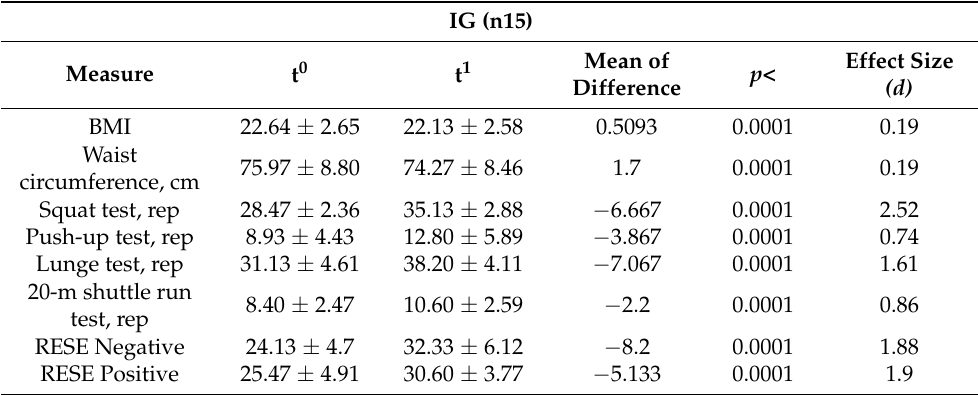
Table 3. Analysis of intervention group.